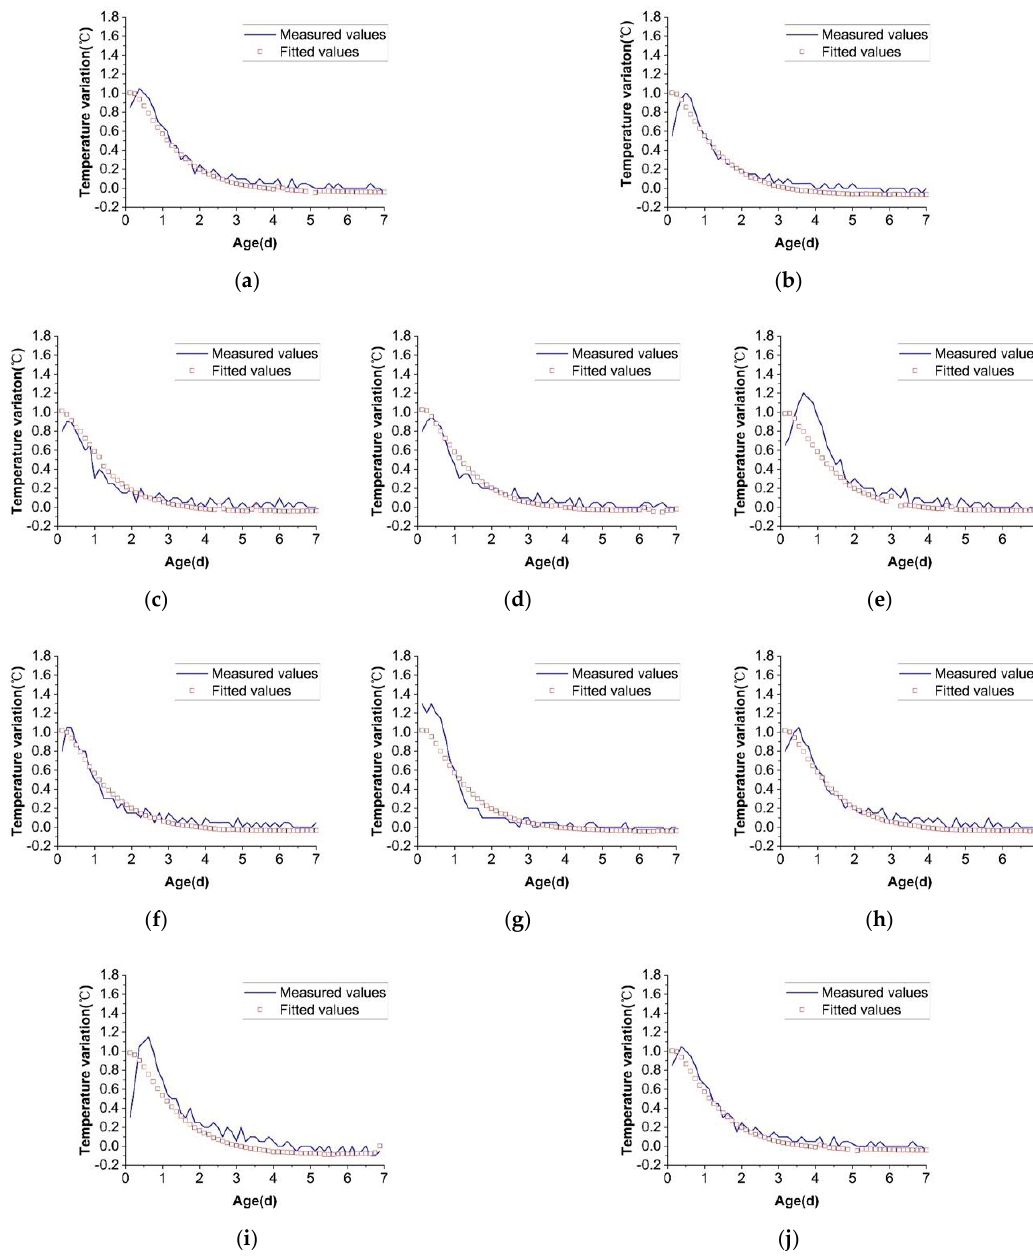
Figure 6. Comparisons of fitted and measured temperature variations for Wudongde dam: ( a )–( j ) the fitted and measured results of the ten selected concrete blocks, respectively.